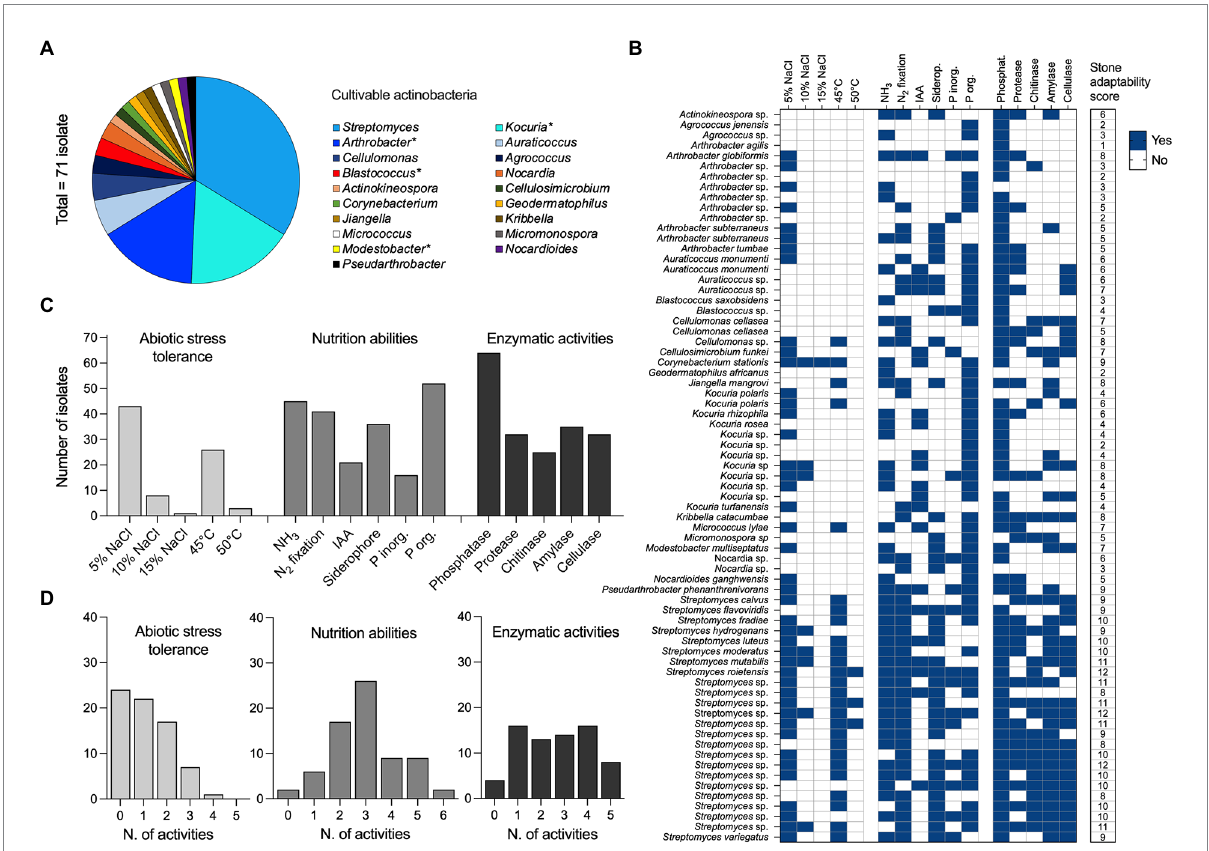
FIGURE 6 Diversity and adaptation of cultivable actinobacteria from stones. (A) Bacterial diversity of culturable bacterial isolates ( n = 71) associated with stone materials was reported at the genus level. All isolates are classified within the Actinobacteria class. (B) The heat map reports the distribution of (i) abiotic stress tolerance ( n = 5; salinity 5%, 10%, and 15% of NaCl, and temperature 45 ° C and 50 ° C), (ii) nutrition abilities ( n = 6; NH 3 and IAA production, fixation of N 2 , the release of siderophore and solubilization of inorganic and organic P) and (iii) enzymatic activities ( n = 5; phosphatase, protease, chitinase, amylase, and cellulase) across the 71 bacterial isolates. The results are expressed as the presence (blue = yes) and the absence (white = no) of each activity tested in vitro . A final score of “stone adaptability” is also computed by summing the presence of activity across the three categories and reported in the last column; the possible maximum value of “stone adaptability” that indicates the presence of all the activity is 16. (C) Total number of bacterial isolates positive to the different activities, within the abiotic stress tolerance, nutrition abilities and enzymatic activities categories listed above. (D) Distribution of bacterial isolates across the activities’ occupancy; range 0 (no one of the activity) to a maximum for the different categories (5 for abiotic stress tolerance and enzymatic activities, and 6 for nutrition abilities).